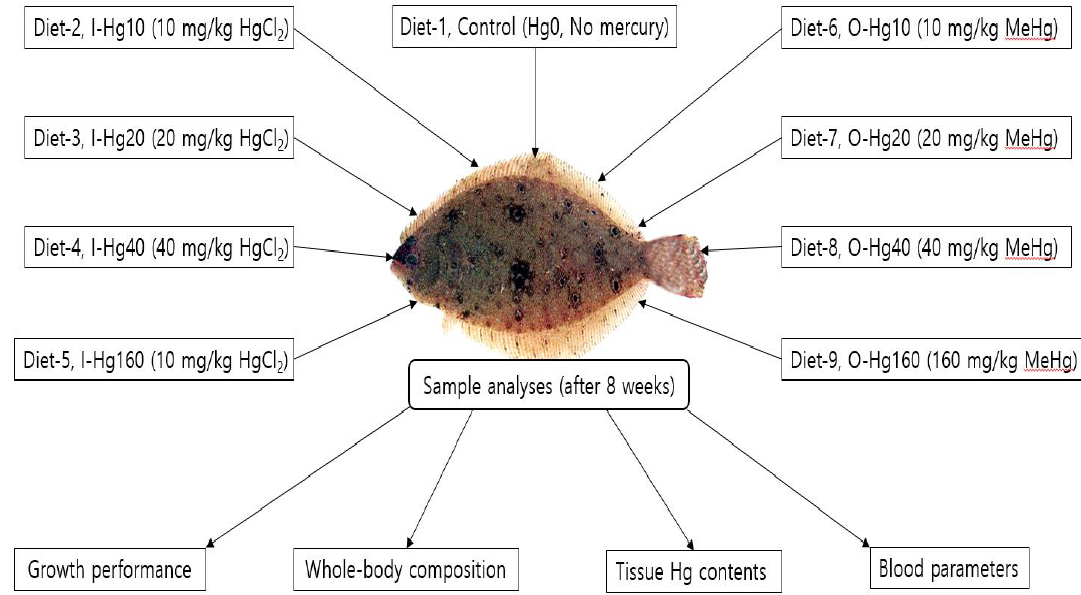
Figure 1. Experimental design and sample analyses of juvenile olive flounder fed with dietary organic (O-Hg) and inorganic (I-Hg) mercury for eight weeks.